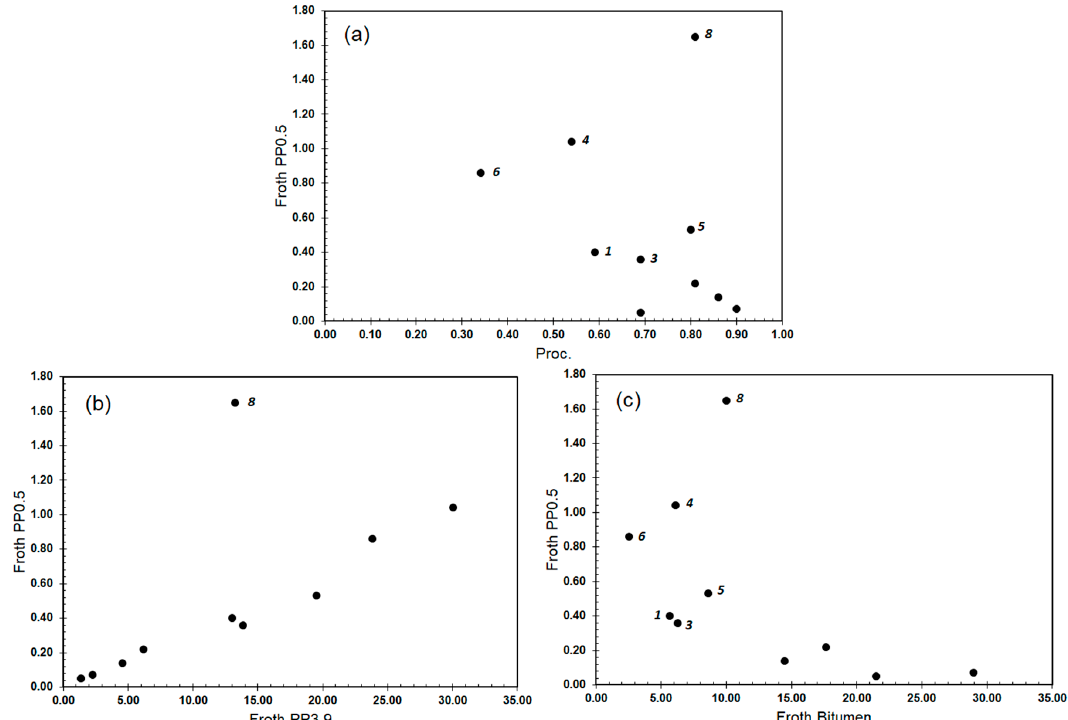
Figure 7. Scatterplots of %fines (pp3.9) and ultrafines (pp0.5) characteristics of froth, ore processability (Proc.), and froth bitumen. ( a ) pp0.5% versus processability. ( b ) pp0.5% versus pp3.9%. ( c ) pp0.5% versus bitumen%. Numbers refer to sample ID listed in Table